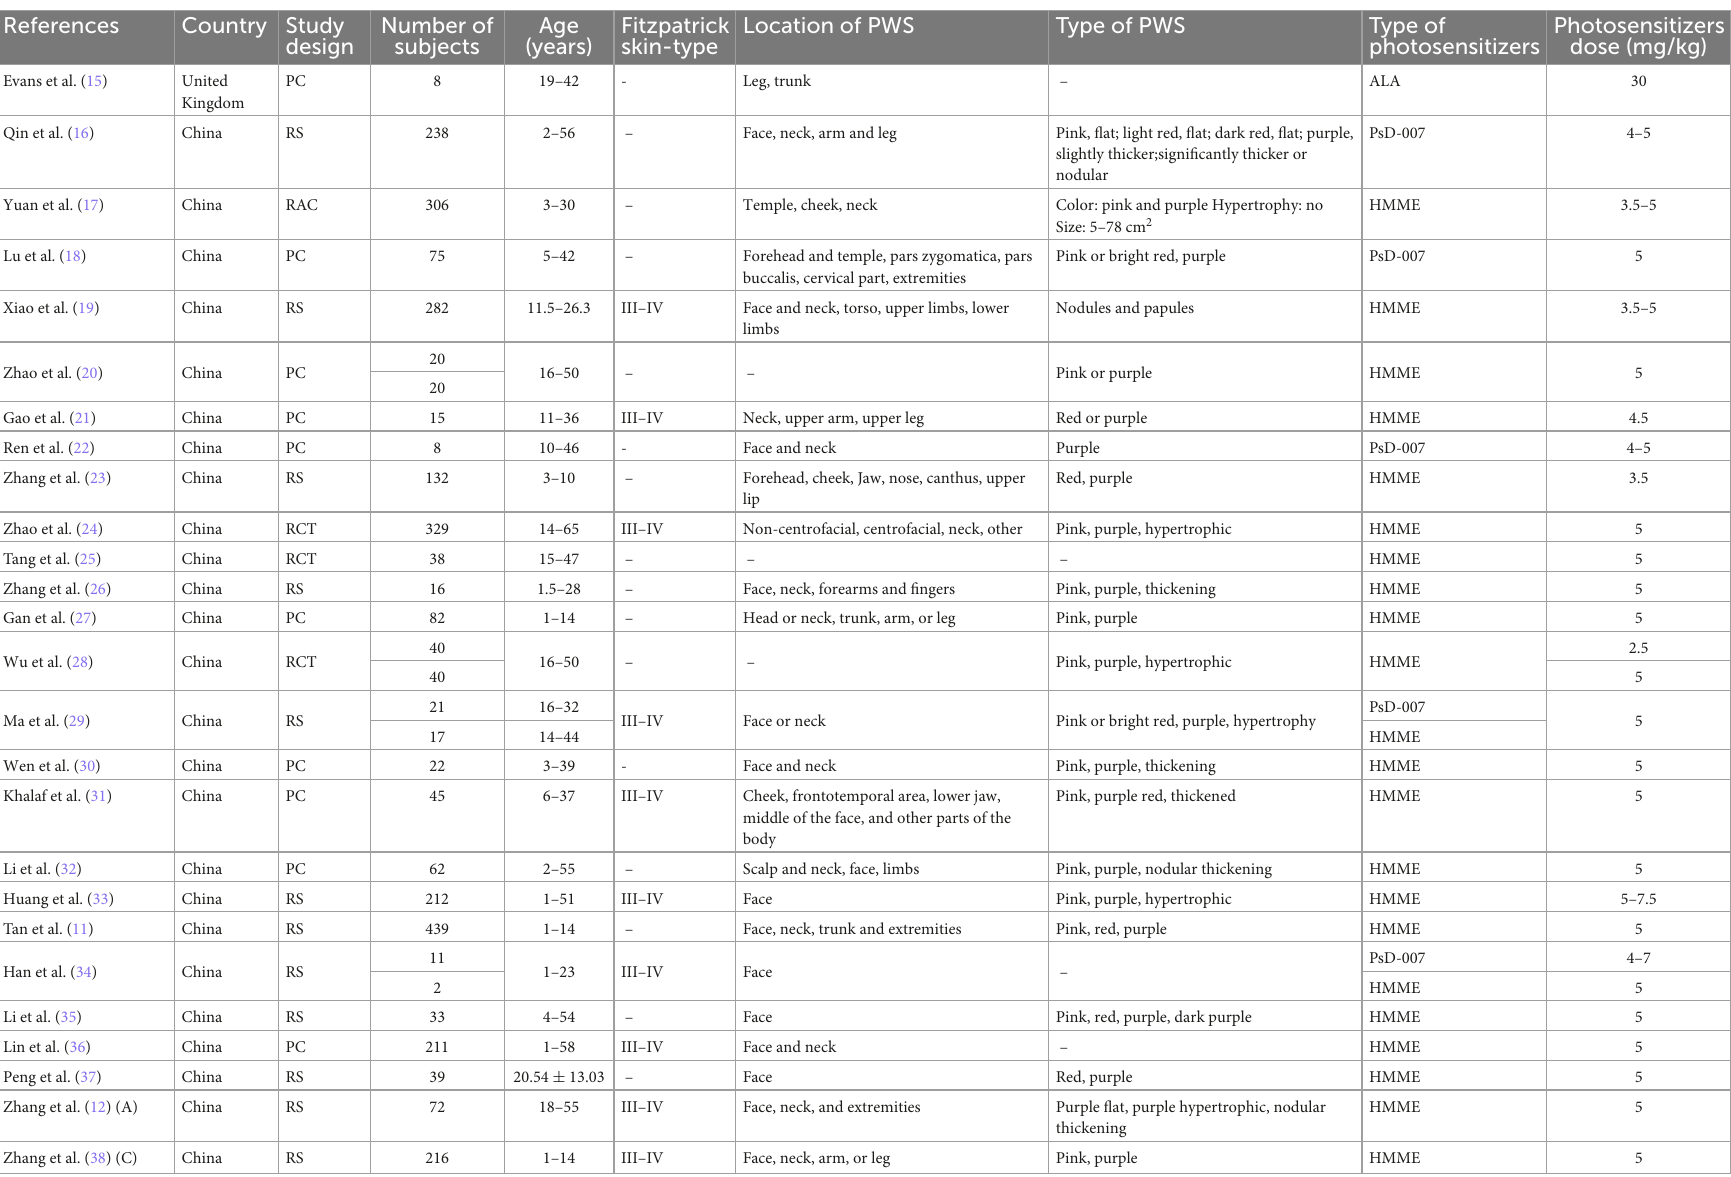
TABLE 1 Characteristics of included studies ( n =